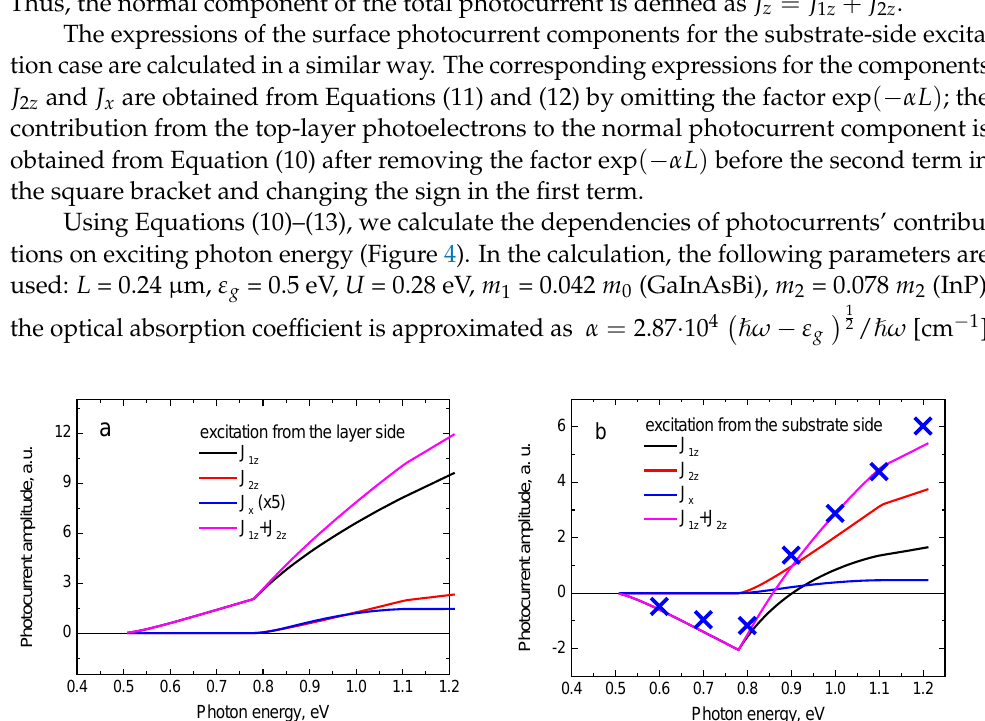
Figure 4. Results of the analytical calculations of different photocurrent components by use of Equations (10)–(13), for the excitation from the GaInAsBi layer side (a) or the InP substrate side (b) Blue crosses show the Monte Carlo simulation results.